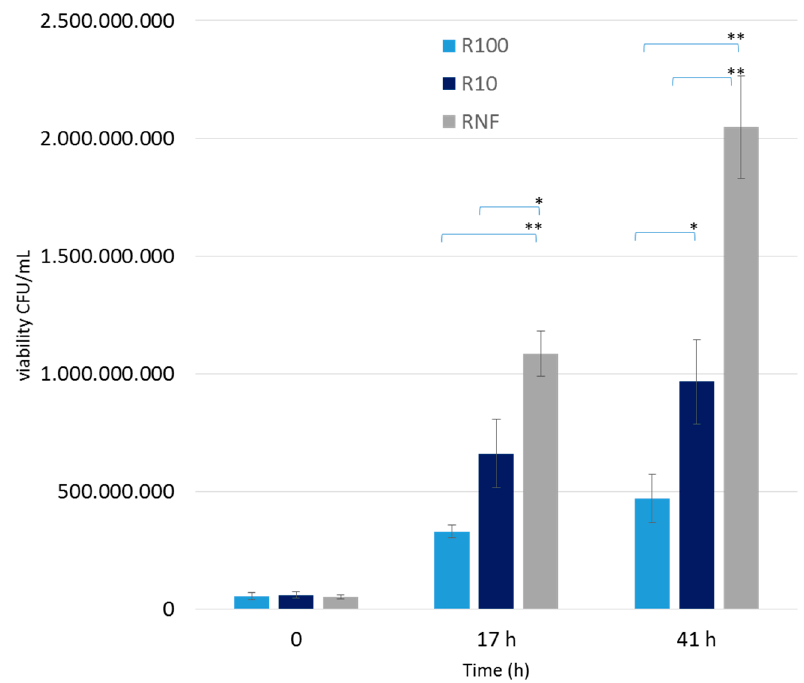
Figure 3. Growth of L. rhamnosus IMC501on sterilized retentate fractions. Data were analyzed by two ‐ tailed non homoscedastic Student’s t ‐ test. * indicates p < 0.05 (Viability results); ** indicates p < 0.005 (Viability results)